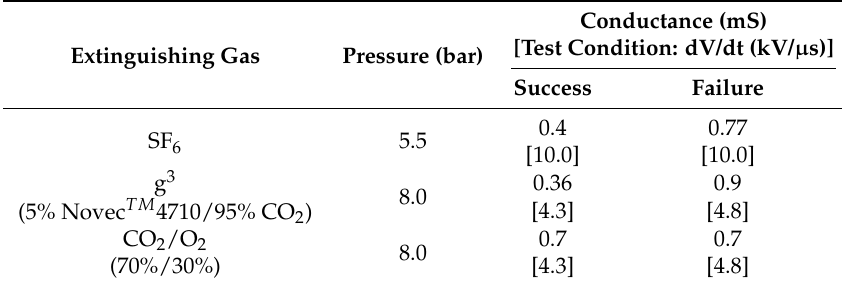
Table 6. Arc-conductance (G200) according to